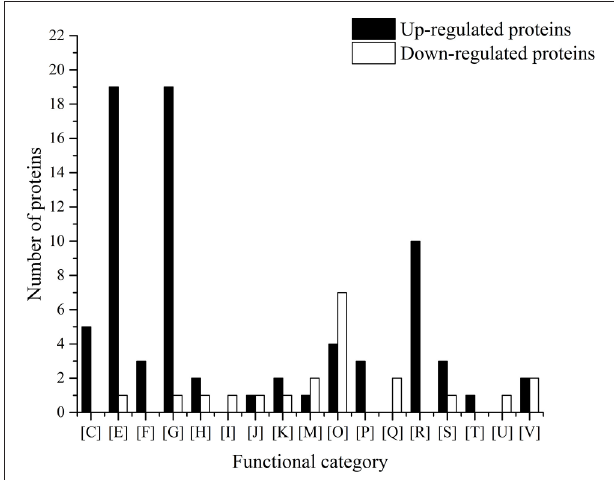
FIGURE 2 | Proteomic profiles of differentially expressed proteins of the parental L. casei Zhang G-0 and gentamycin-resistant L. casei Zhang-G-1200 strains. Clusters of orthologous groups (COG) functional categories: [C], Energy production and conversion; [E], Amino acid transport and metabolism; [F] Nucleotide transport and metabolism; [G], Carbohydrate transport and metabolism; [H], Coenzyme transport and metabolism; [I], Lipid transport and metabolism; [J], Translation, ribosomal structure and biogenesis; [K], Transcription; [L], Replication, recombination and repair; [M], Cell wall/membrane/envelope biogenesis; [O], Posttranslational modification, protein turnover, chaperones; [P], Inorganic ion transport and metabolism; [Q], Secondary metabolites biosynthesis, transport and catabolism; [R], General function prediction only; [S], Function unknown; [T], Signal